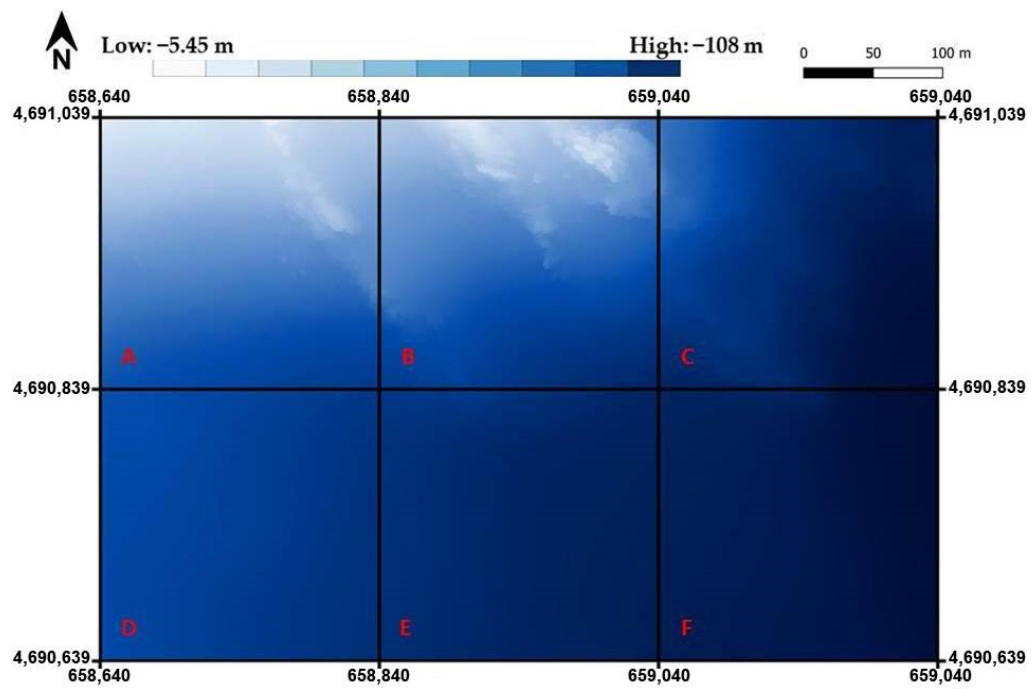
Figure 5. Division of the study area into 6 sectors ( A – F ), each of 200 m on each side. Each sector has different seafloor patterns; for example, sector B has large variations in depth while sector D has less abrupt and more linear variations in depth.